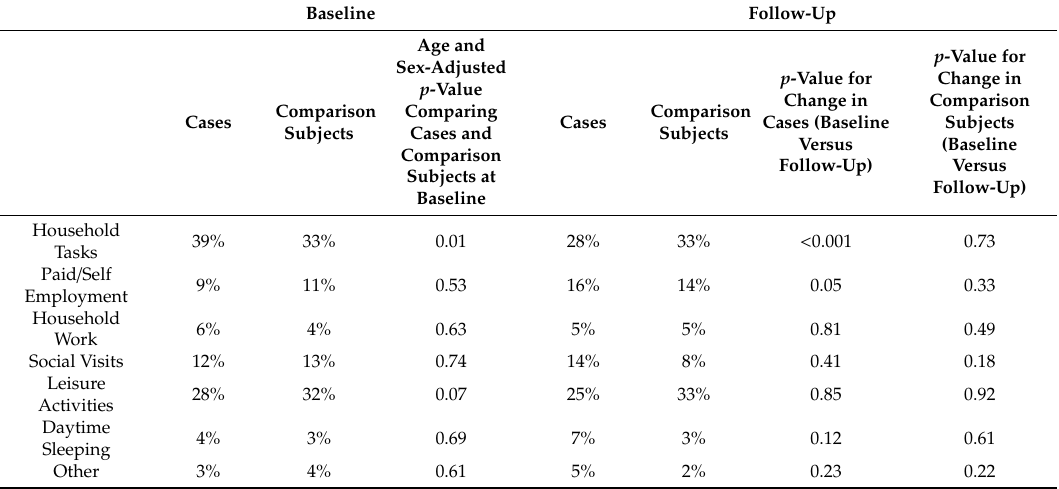
Table 3. Mean percentage time spent in di ff erent activities for cases and comparison subjects, at baseline and follow-up.